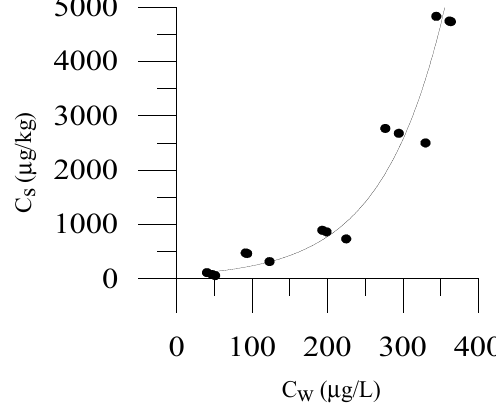
4-nonylphenol in